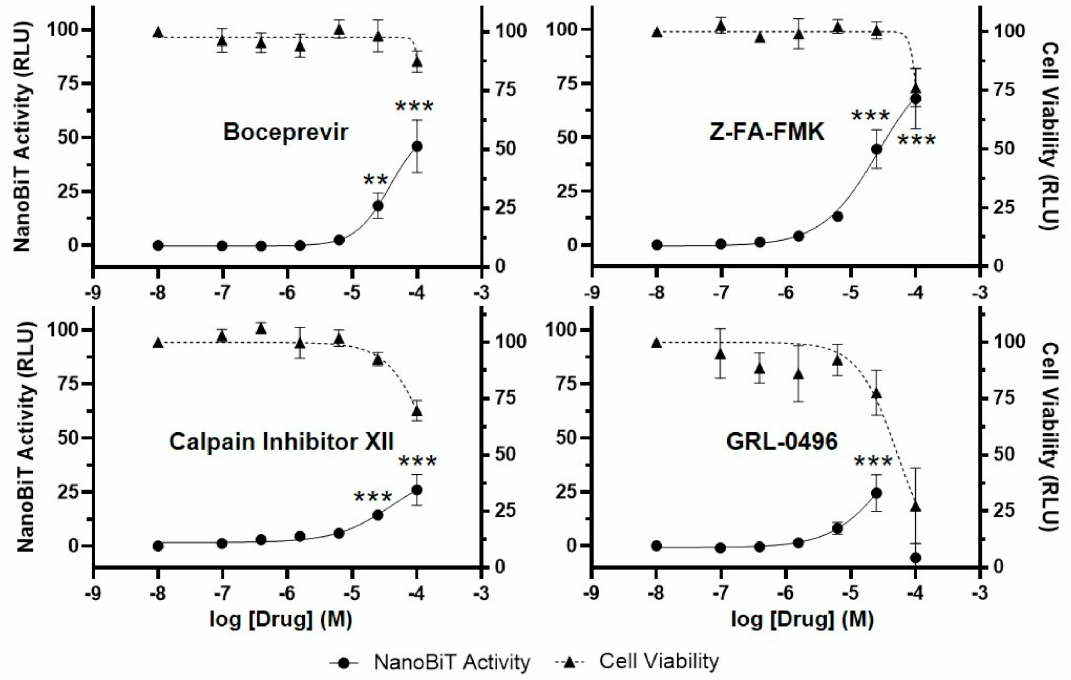
Figure 5. Boceprevir, Z-FA-FMK, calpain inhibitor XII, and GRL-0496, inhibit SARS-CoV-2 3CL pro in a cell-based luciferase complementation assay. To determine if other compounds are active against SARS-CoV-2 3CL pro in cells, 293T cells were transfected with the S-L-GFP lentiviral vector, and DMSO (control) or compounds (0.1, 0.4, 1.6, 6.3, 25, or 100 µ M) were added. NanoBiT activity (circle, left axis) and cell viability (measured with the CellTiter-Glo 2.0 assay; triangle, right axis) were analyzed 30 h post-transfection and are expressed as relative luciferase units (RLU). Cell viability data were normalized to the DMSO sample, which was set to 100%. NanoBiT data were normalized to the DMSO and 100 µ M GC376 samples, which were set to 0 and 100%, respectively. The data represent the mean ± standard deviation of three independent experiments; ** p < 0.01, *** p < 0.001 (relative to no-drug; one-way ANOVA with Dunnett’s